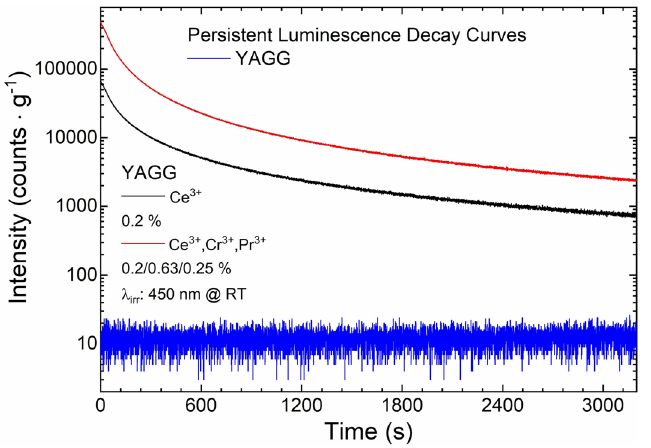
Figure 8. PersL decay curves of YAGG:Ce 3+ and YAGG:Ce 3+ ,Cr 3+ ,Pr 3+ nanophosphors. λ irr : 450 nm (1 mW cm −2 ) for 5 min at RT and the observed signal intensity was corrected by mass.